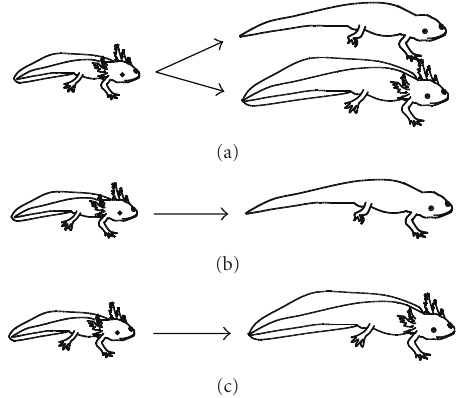
Figure 1: The tiger salamander radiation exemplifies the develop- mental plasticity hypothesis of ecological speciation [13–15,